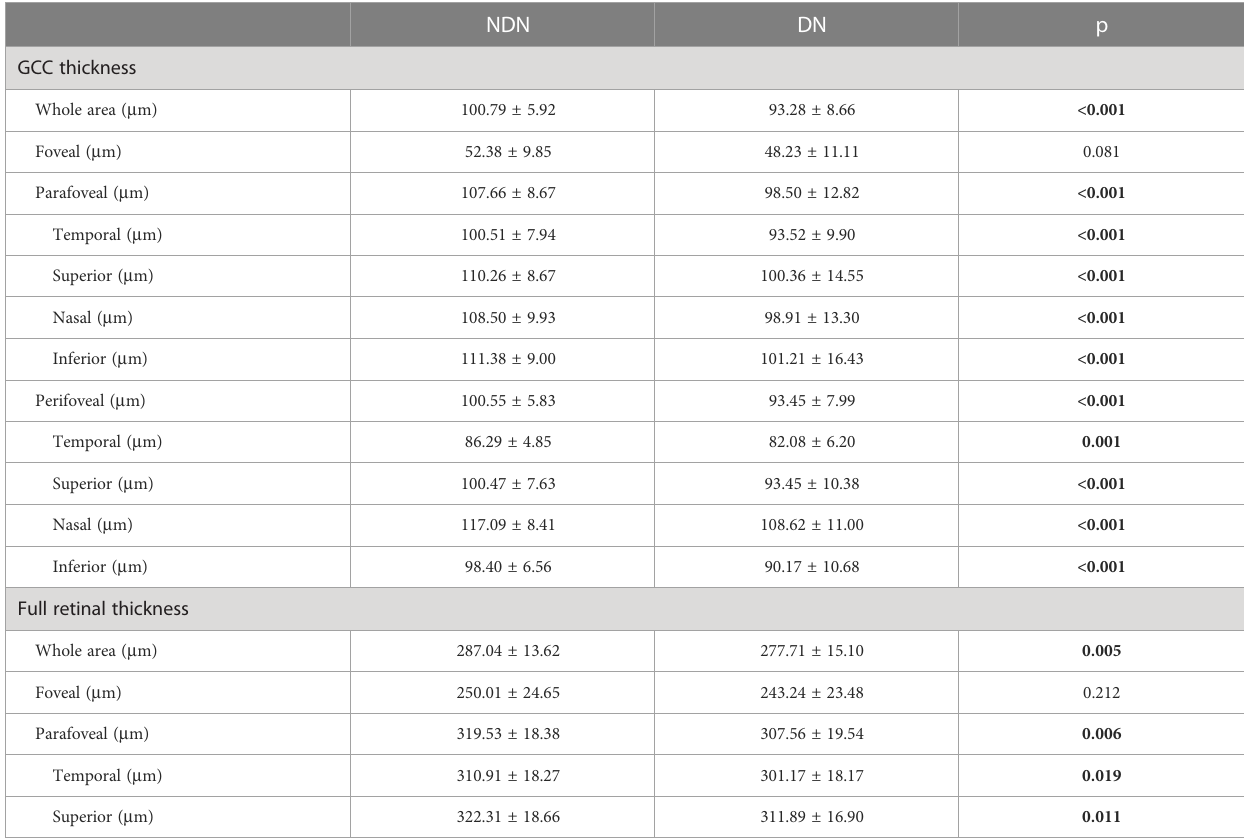
in scatter diagrams (Figure 2). In multivariate linear regression analysis adjusted for sex, age and DM duration for eGFR, representative OCTA parameters with statistical signi fi cance including FAZ area, SCP and DCP vessel densities (whole area), GCC and full retinal thicknesses (whole area), peripapillary TABLE 3 Retinal thickness in the macular